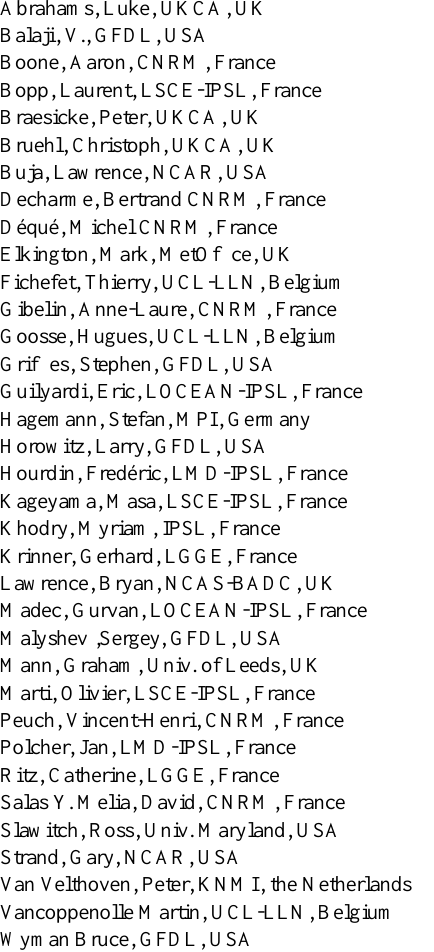
Table A1. List of climate scientists who contributed to the METAFOR controlled vocabulary, whether during face to face in- terviews, phone calls or e-mail